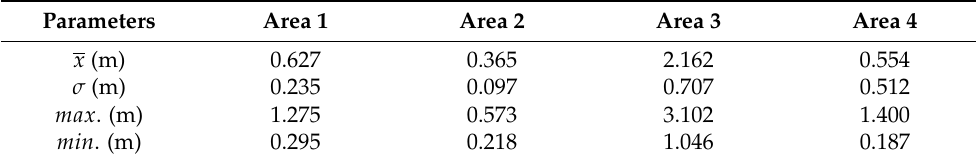
Table 7. Statistical parameters of the dH analysis of the set of contour lines.